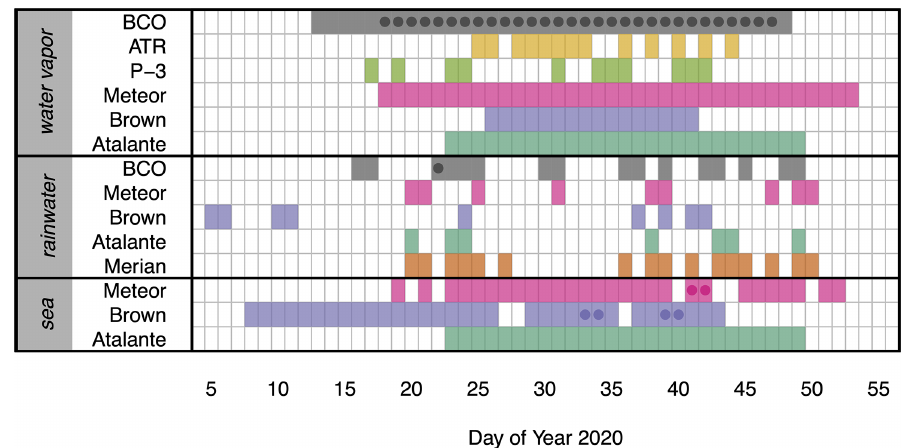
Figure 3. Timeline of continuous (water vapor) and discrete (rain and seawater) isotopic sampling during EUREC 4 A. Dots either represent days when two laser analyzers were operating at the BCO or indicate intensive observation periods for rain or seawater (see main text for additional details). Discrete samples are represented by their collection times, which, in the case of Brown rainwater, were delayed in some cases by up to several days following precipitation.